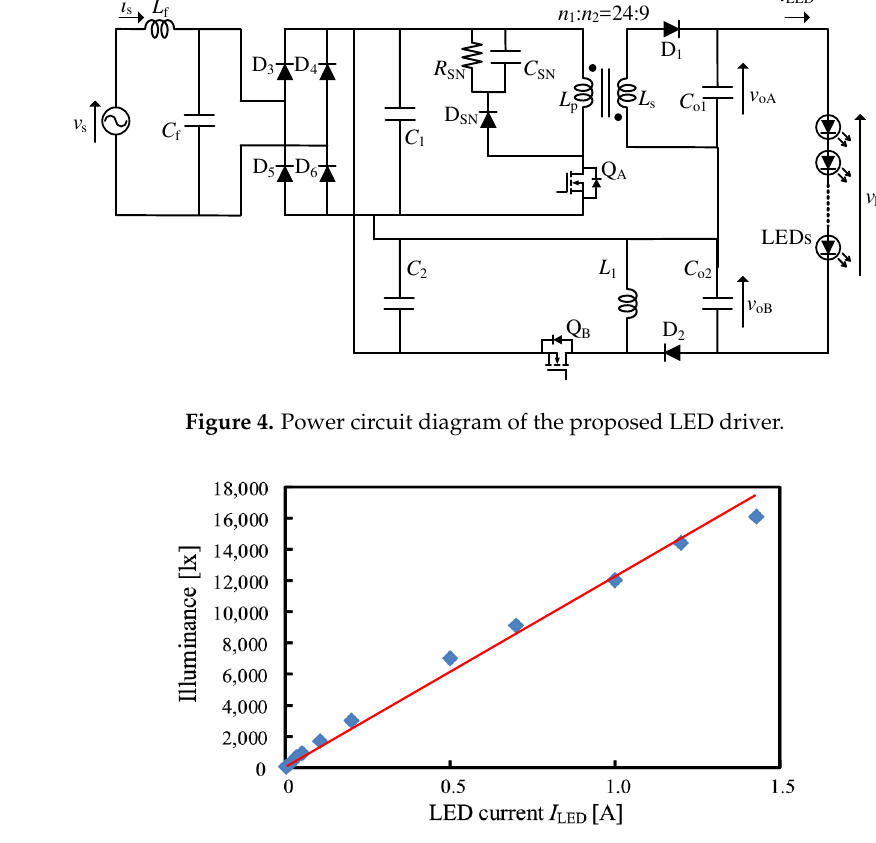
Figure 5. Relationship between the LED current and LED illuminance.